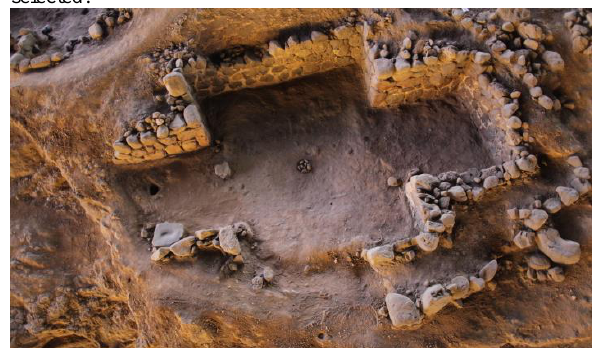
Figure 9. Example of a nadiral and oblique image acquired from the pole platform system.